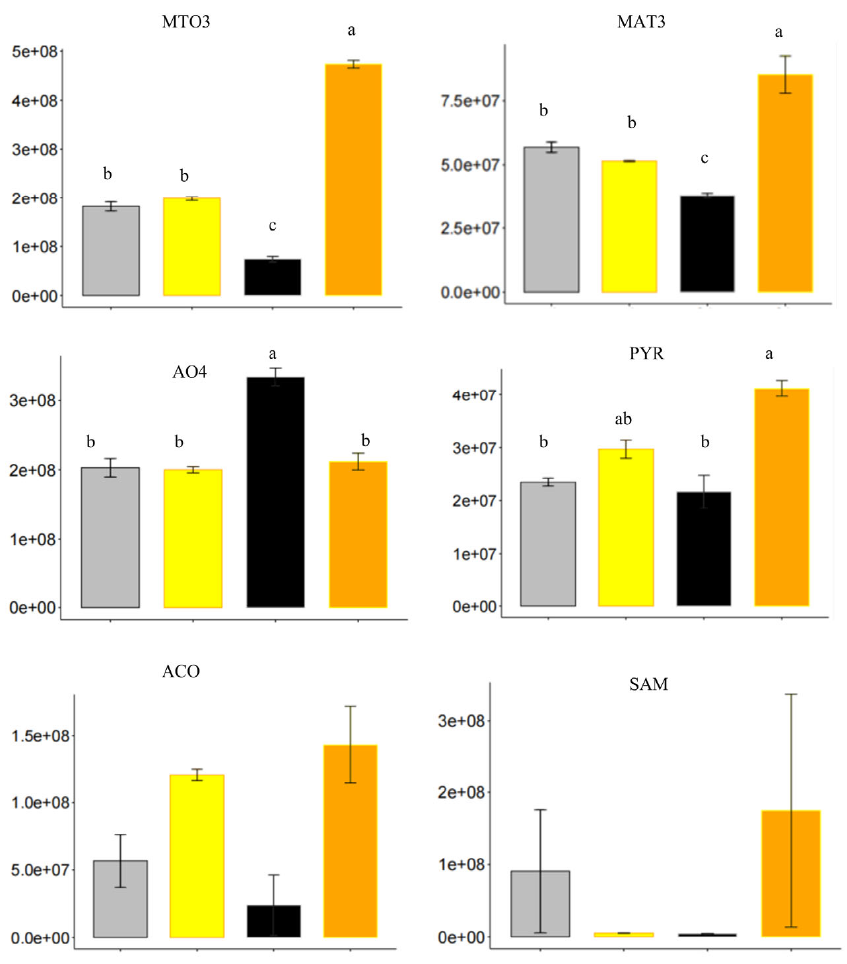
Figure 8. Quantification of the proteins involved in the hormone synthesis and signaling in 4 samples, Col − (black), Col+ (orange), prt6 − (grey), prt6 + (yellow). Significant levels were only shown on the proteins which passed the 2 factors ANOVA analysis and have interaction effects.